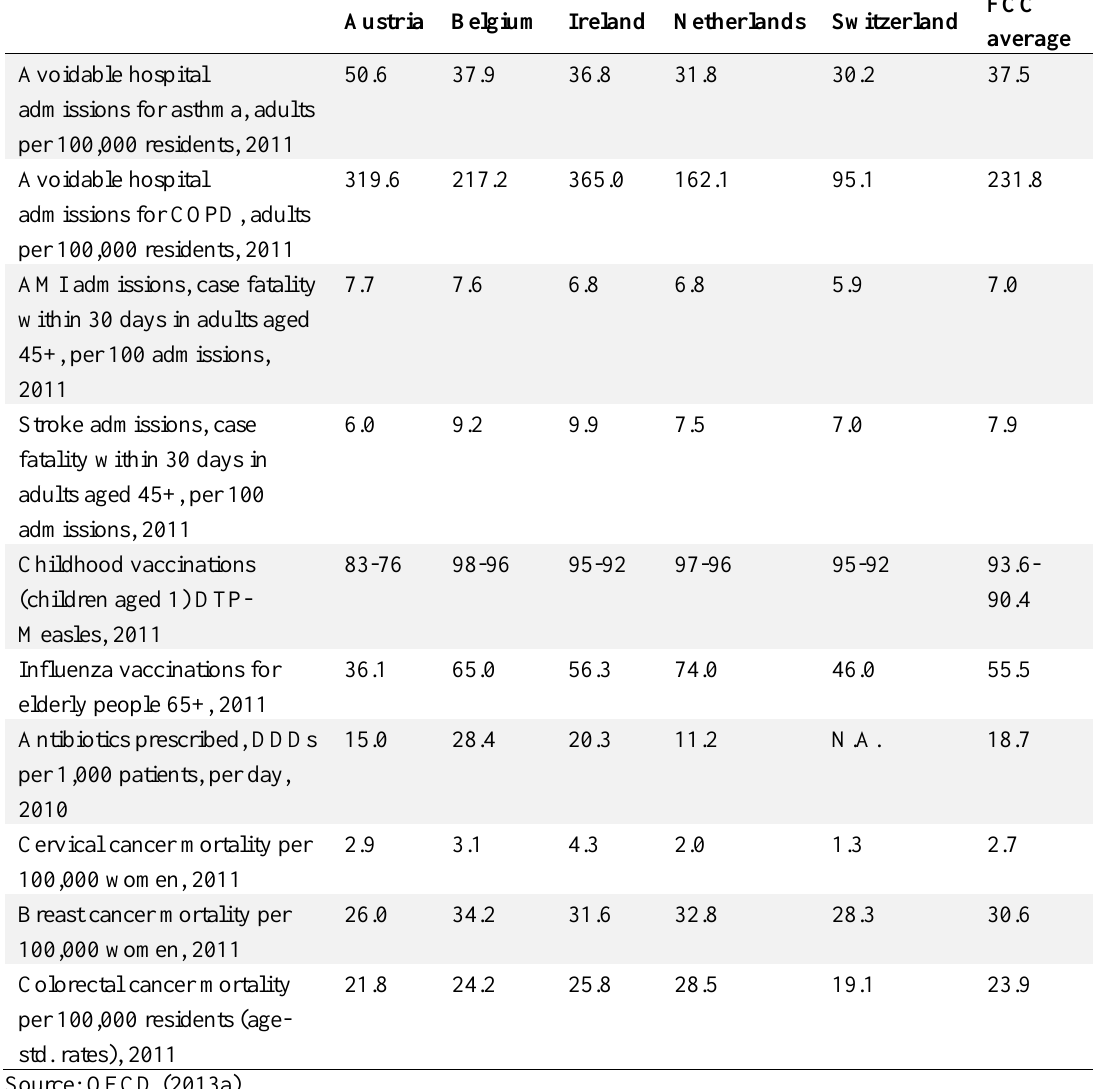
Table 5B: Health care system quality